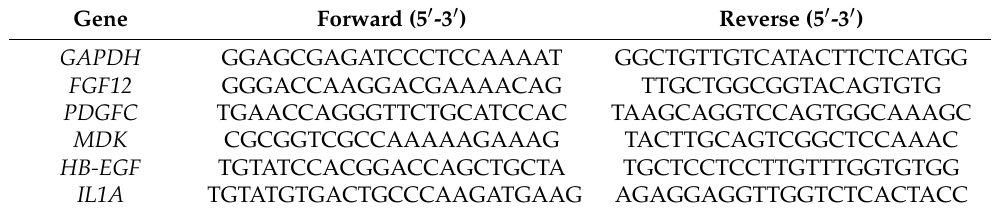
Table 2. Primer sequences used in the qRT-PCR analysis.